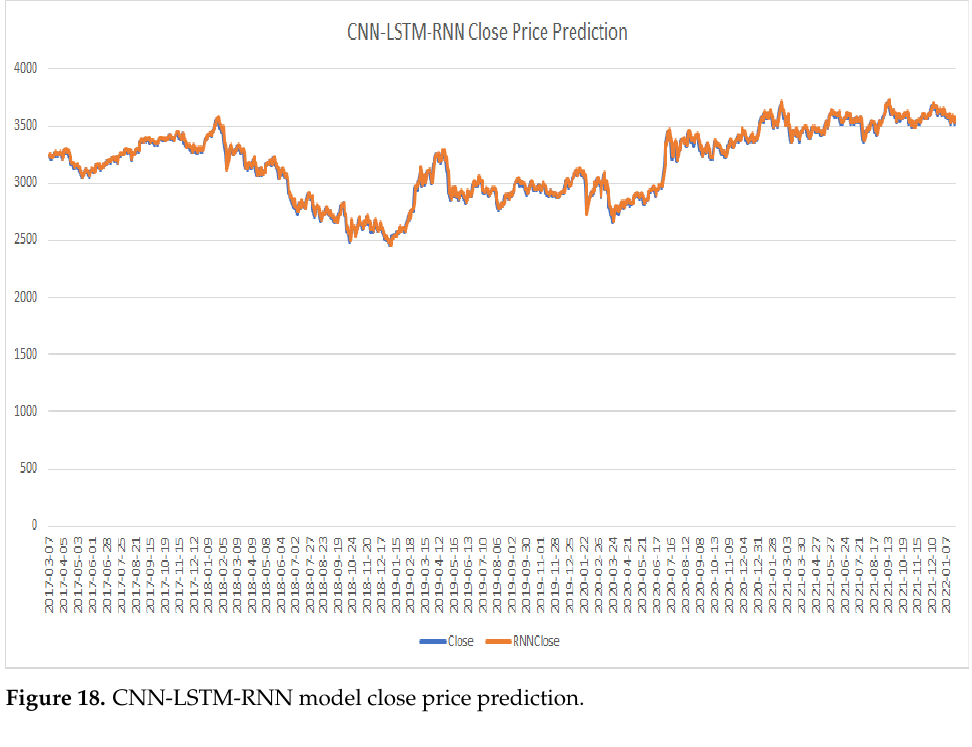
Figure 18. CNN-LSTM-RNN model close price prediction.